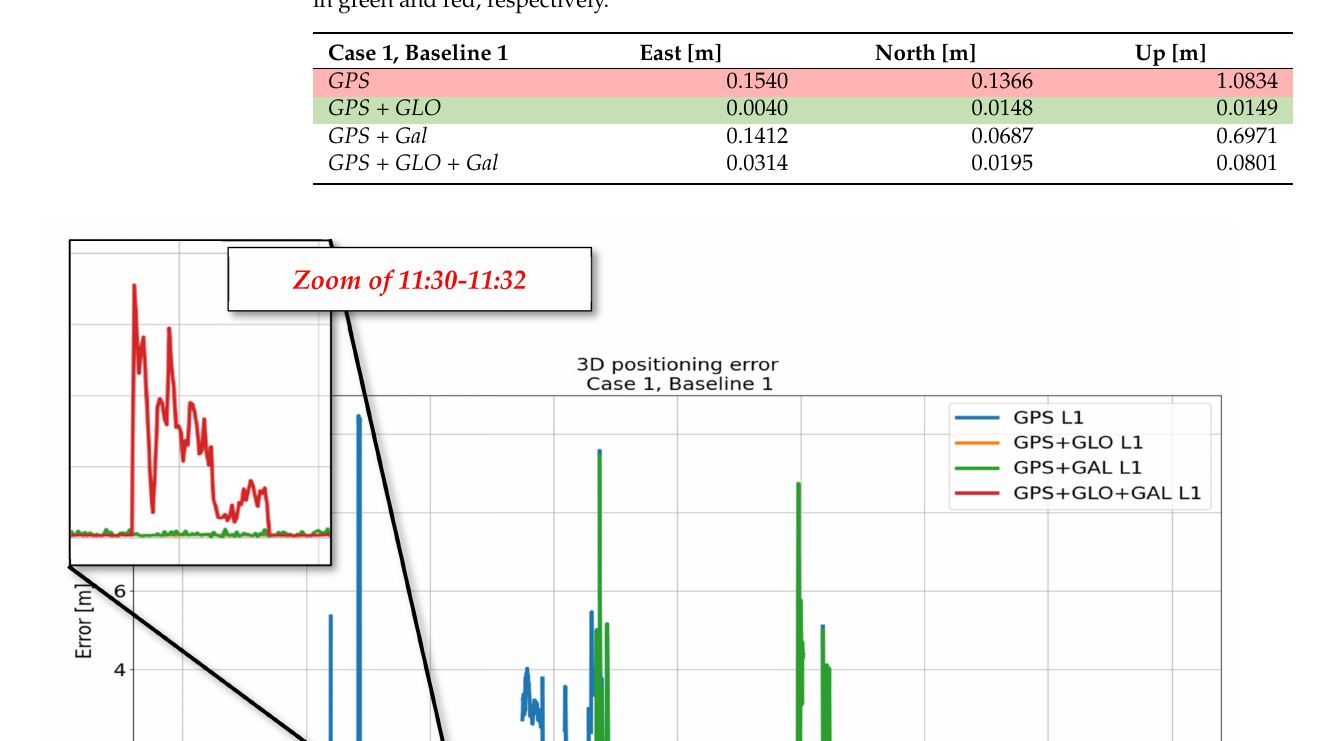
Table 5. Position standard deviation in east, north, and up direction during the jamming incident of Case 1, baseline 1 (11 km)—the full 3D positioning error is shown in Figure 10. The solution is based entirely on L1 phase data. The solution with the least error and largest errors are highlighted in green and red, respectively.